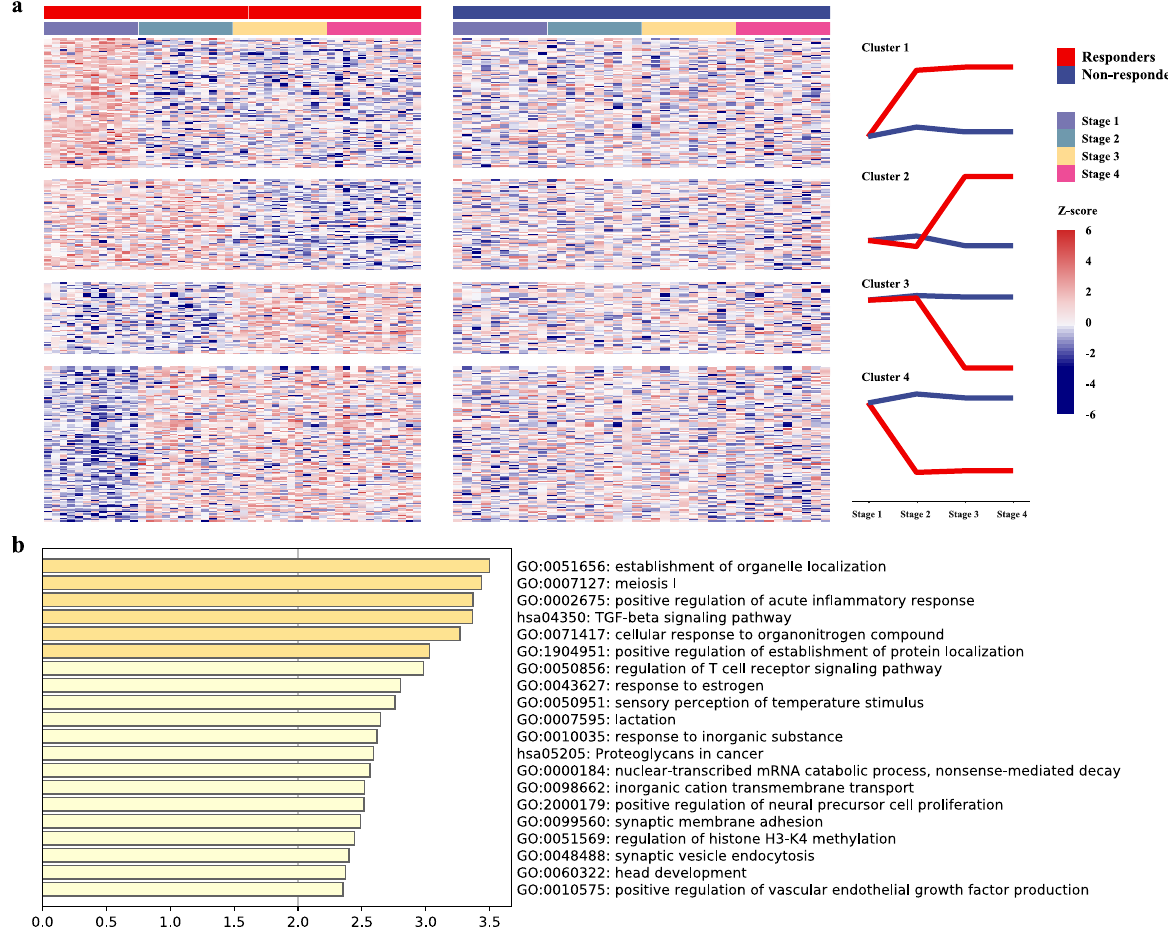
Fig. 8 Differentially altered TSSs between responders and nonresponders after neoadjuvant chemotherapy. a Heatmaps summarizing changes in TSS region coverage over time in two major molecular functional groups in responders (PR) and nonresponders (SD). Samples are ordered from left to right by patient identi fi cation for each stage. Red and blue represent relatively high and low coverage, respectively. Stage 1 represents pretreatment, stage 2 represents post-1 cycle, stage 3 represents post-3/4 cycles, and stage 4 represents post-8 cycles. b The top 20 signi fi cantly altered pathways after neoadjuvant chemotherapy in responders. Red and blue represent relatively high and low coverage,